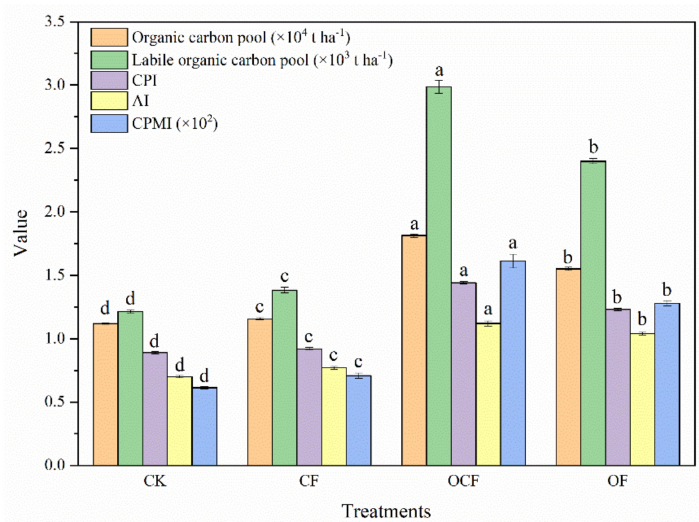
Figure 3. Soil organic carbon pool (0–20 cm) in tobacco growing field under different fertilizations. CK, no fertilization; CF, single application of chemical fertilizer; OCF, application of organic-inor- ganic fertilizer; OF, single application of organic fertilizer. CPI, carbon pool index; AI, activity index of the carbon pool; CPMI, carbon pool management index. Different low case letters each line indic-ate significant differences ( p < 0.05) among treatments using the least significant difference